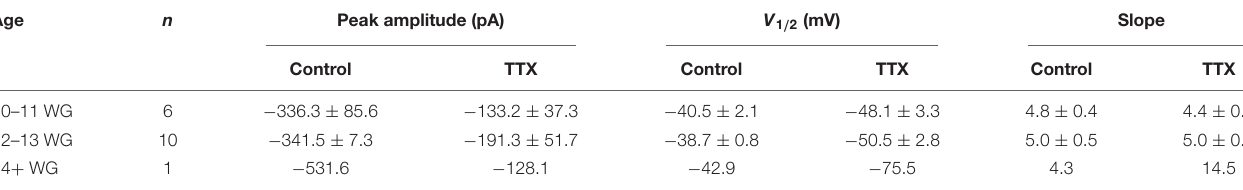
TABLE 6 | Peak Na + current amplitude, V 1 / 2 , and slope for each age group, before and after, the addition of TTX (1 µ